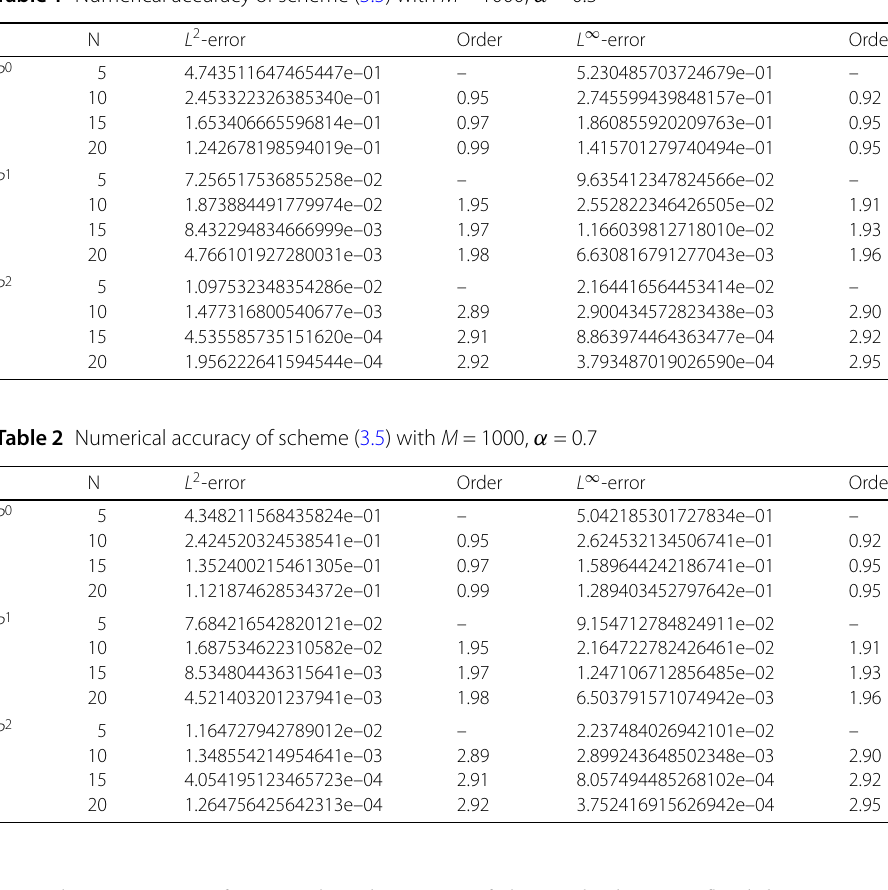
Table 1 Numerical accuracy of scheme (3.5) with M = 1000, α = 0.3